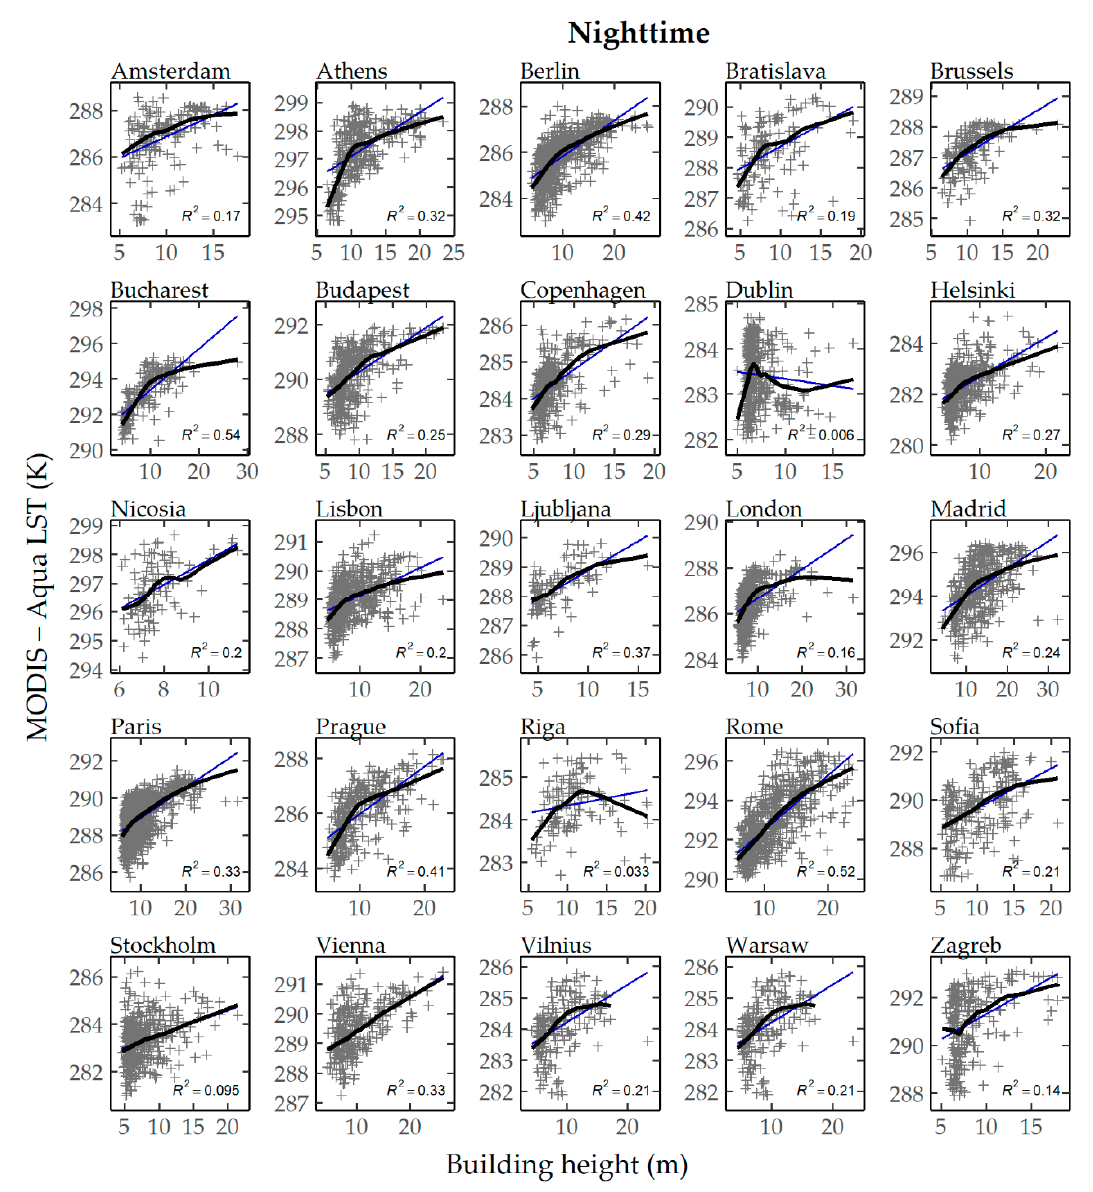
Figure 7. As in Figure 6, during nighttime.